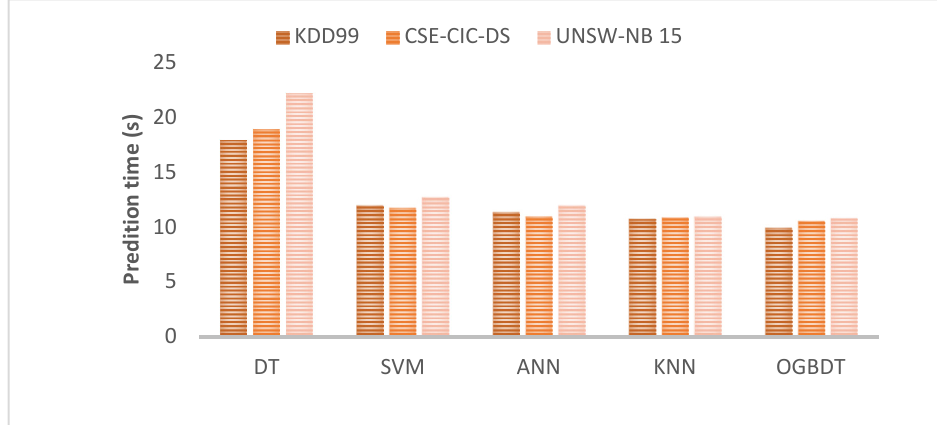
Figure 8. Prediction time comparison.